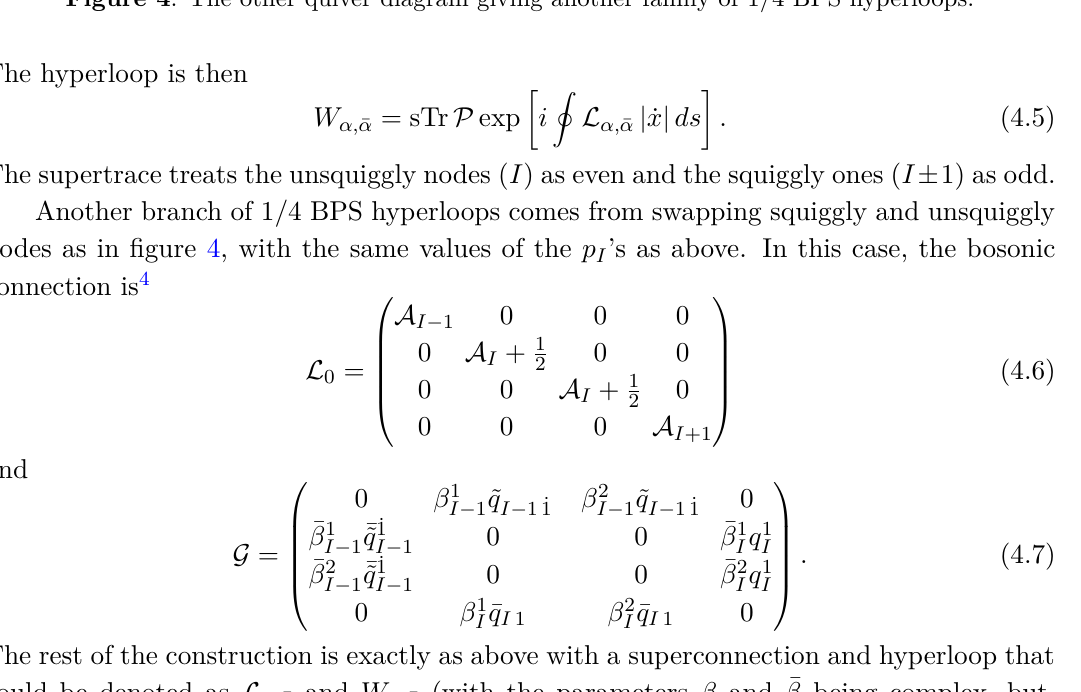
Figure 4 . The other quiver diagram giving another family of 1 / 4 BPS